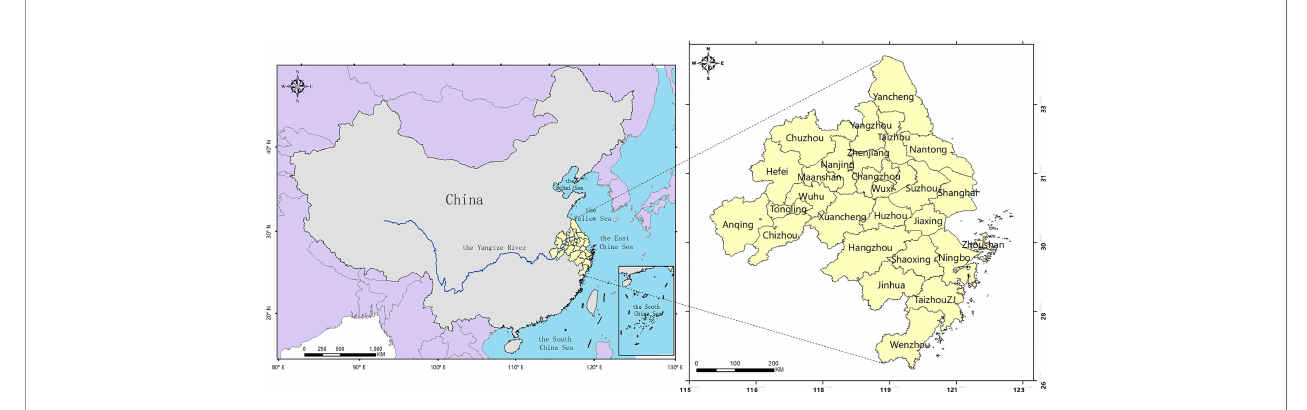
FIGURE 2 | Geographical location of 27 central cities in